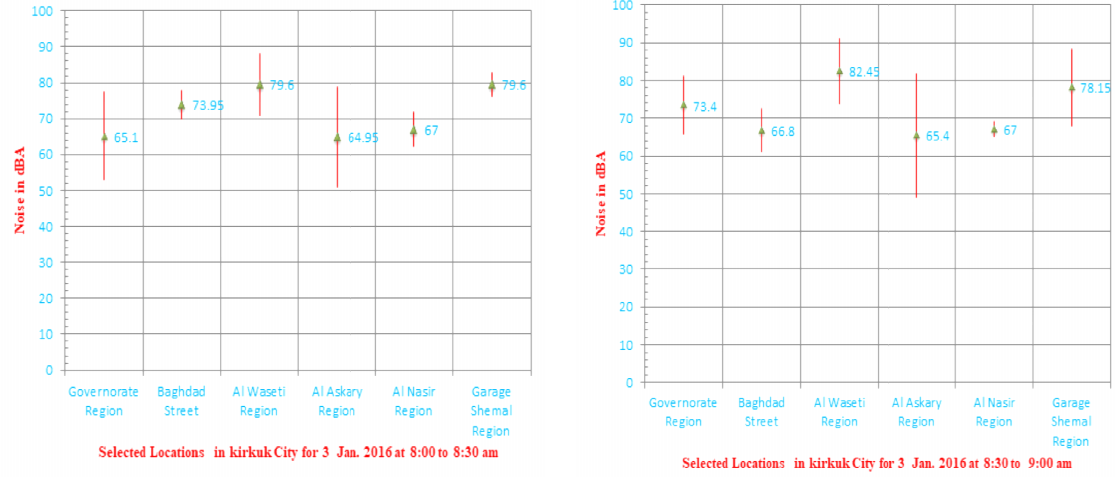
Fig. 7. Max, Min and Average Hourly Noise Distribution for the traffic flow 3 Jan. 2015 Kirkuk City.